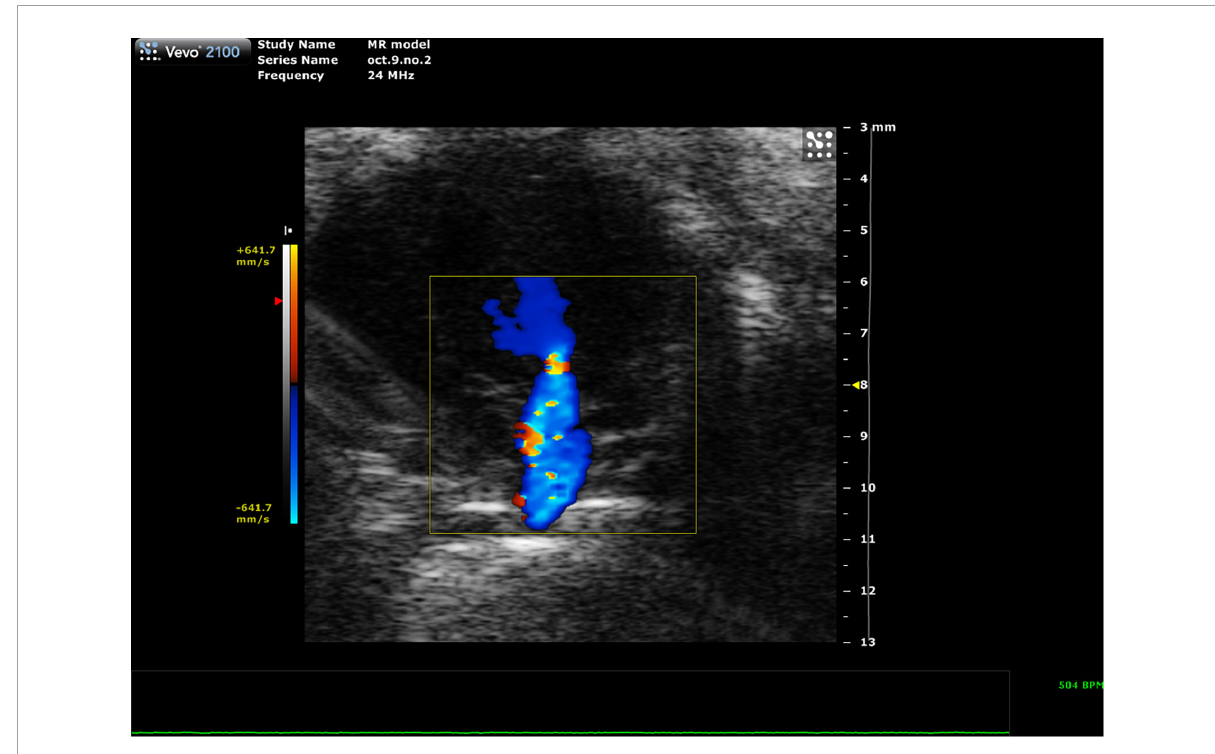
FIGURE11 Representative image showing a mixed color pattern of systolic backflow from the left ventricle to the left atrium in severe mitral regurgitation.